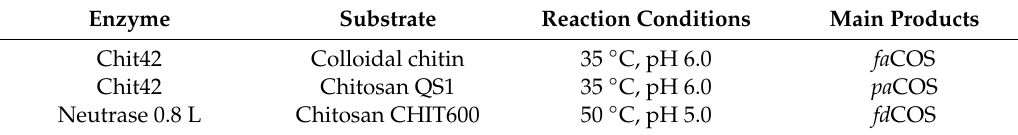
Table 4. Experimental conditions for the preparation of COS